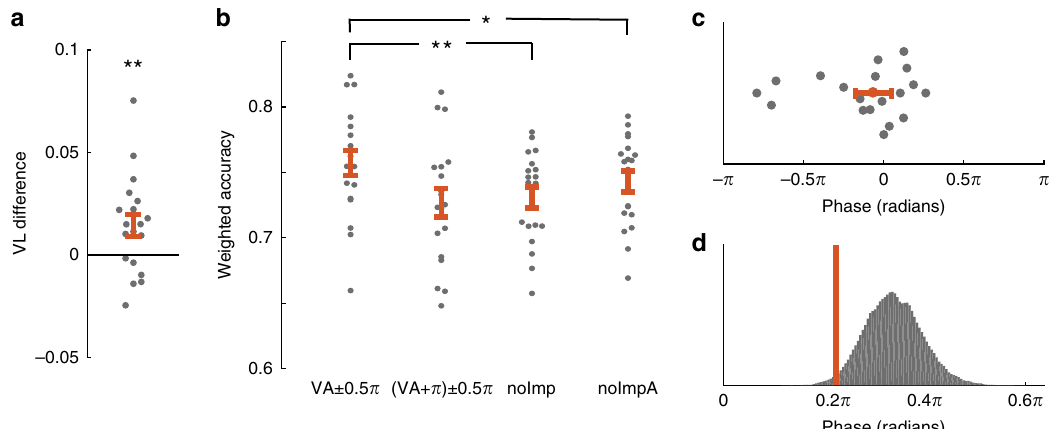
Fig. 2 Behavioral results. a The relatively change in vector length (VL) for accuracy. b Weighted accuracy for the VA, VA + π , the no Impulse (noImp), a no Impulse after alignment to the VA (noImpA). c Linear phase plot of the phase differences between the vector phase of the accuracy and decoding. d Histogram of all permutations of absolute phase difference and observed phase difference (orange line). Error bars represent the standard error of the mean ( n = 19; in ( c ) it represents the circular variance). a One-tailed paired t -test. b Two-tailed paired t -test, ** p < 0.01, * p <